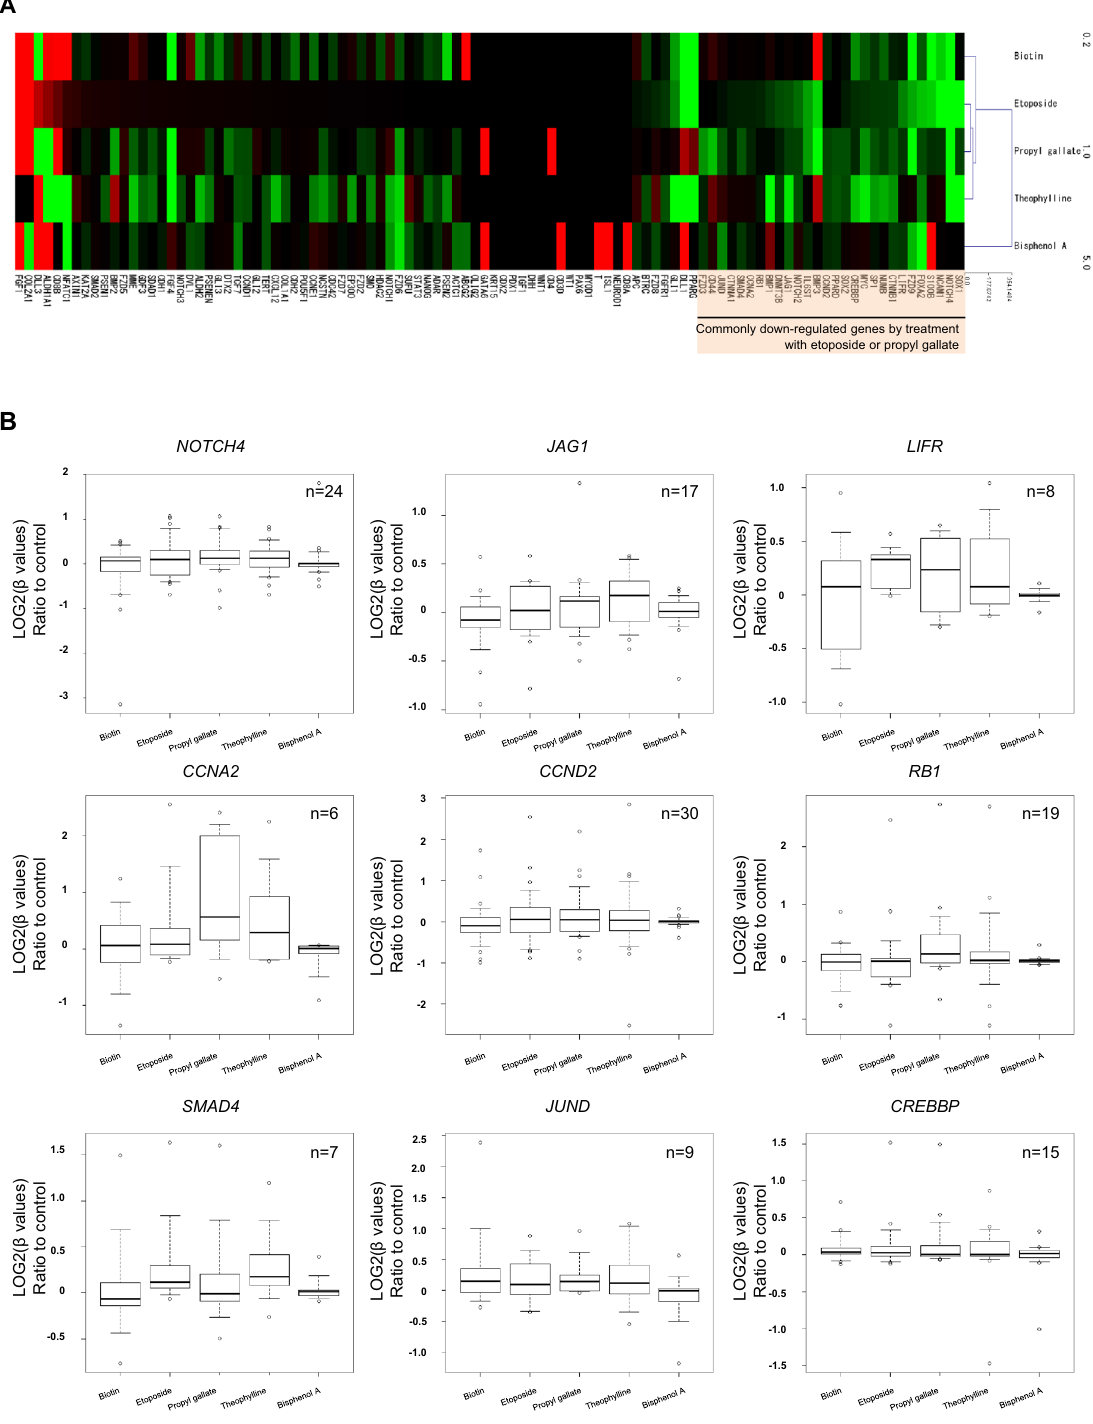
Figure 5. Effects of hypermethylation agents on the levels of gene expression and DNA methylation of stemness-related genes in human iPSCs. ( A ) Hierarchical cluster analysis of the gene expression profiles of 100 stemness-related genes in human iPSCs. Cells were treated with biotin, etoposide, and propyl gallate (category B, hypermethylation agents); theophylline (category A, hypomethylation agent); and bisphenol A (category C, intermediated epigenetic agent) for 48 h. Data are presented as the fold change of gene expression relative to the vehicle control. ( B ) Effects of hypermethylation agents on DNA methylation rate at CpG sites around the locus of NOTCH4 , JAG1 , LIFR , CCNA2 , CCND2 , RB1 , SMAD4 , JUND , and CREBBP genes. Data are presented as log2 (β-values) ratio to the vehicle control. The total number (n) indicates the number of CpG sites in each gene. See also Table